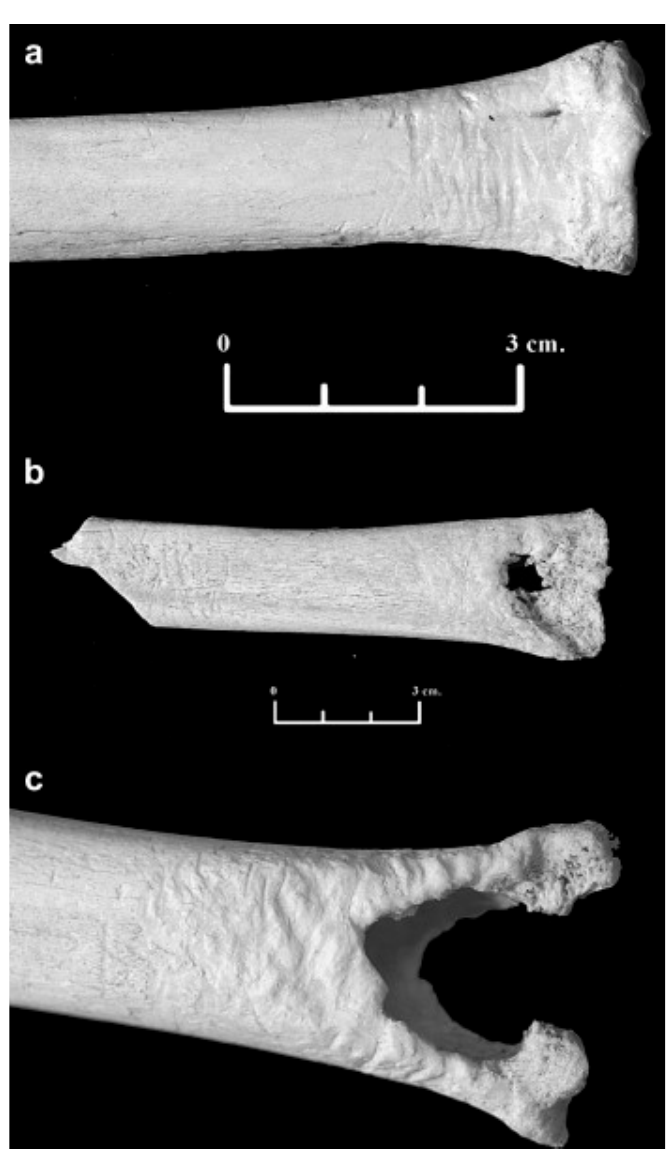
Figure 10. Animal bones gnawed by ungulates in an experiment: ( a ) transversal grooves, ( b ) exposed trabeculae and disappearing epiphysis, ( c ) fork-shaped distal long bone. Reproduced with permission from C á ceres et al. [141]; published by Elsevier,